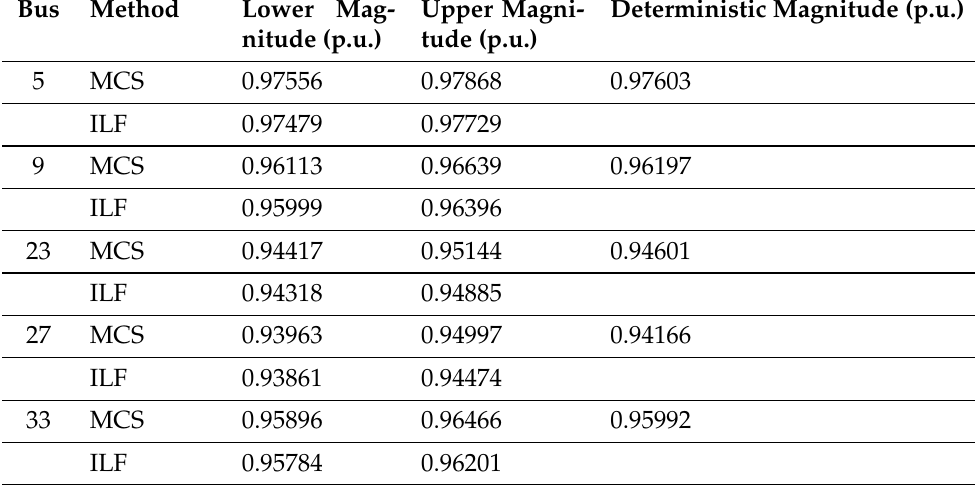
Table 2. Voltage Magnitude—IEEE 34-bus test